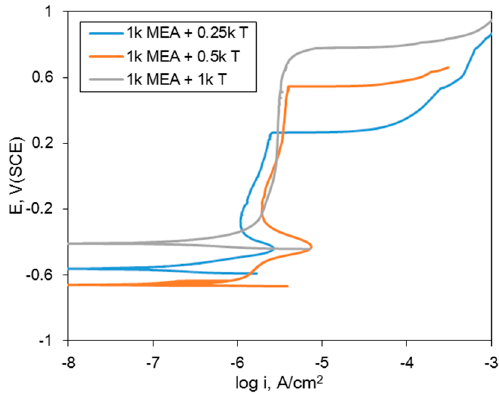
Figure 5. Effect of co-addition of corrosion inhibitors on the anodic polarization curve of DCI in deaerated [tap water + 1 k ppm monoethanolamine (MEA) + x ppm tungstate (T)] at 30 °C.